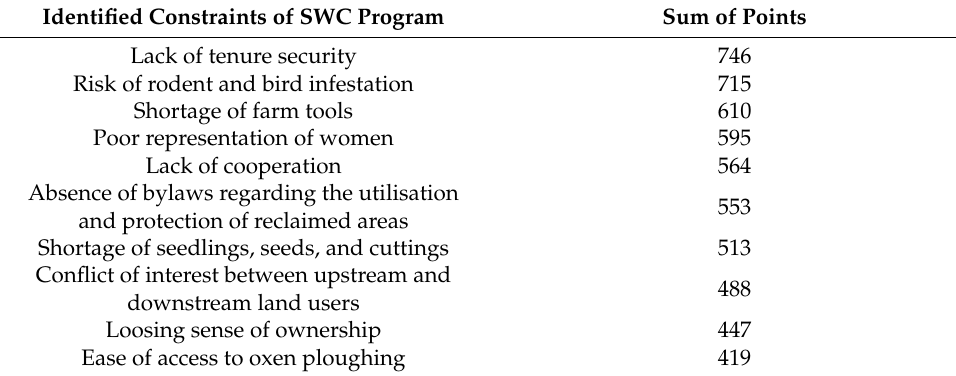
Table 7. Significant constraints of the SWC